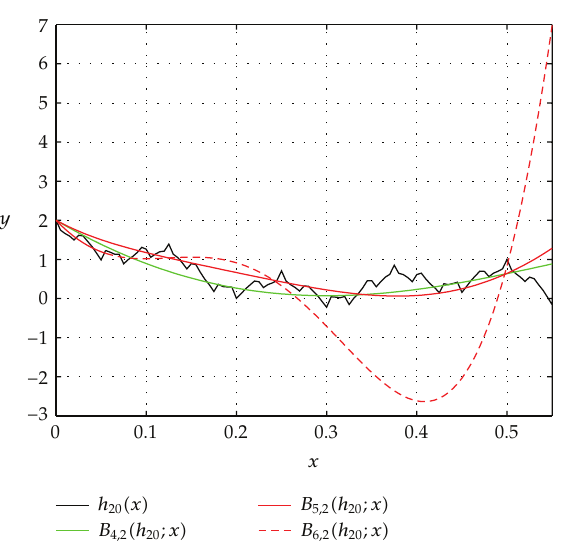
Figure 4: Graphs of y (cid:6) h 20 (cid:2) x (cid:3) and y (cid:6) B n, 2 (cid:2) f ; x (cid:3) , n (cid:6) 4 , 5 , 6.